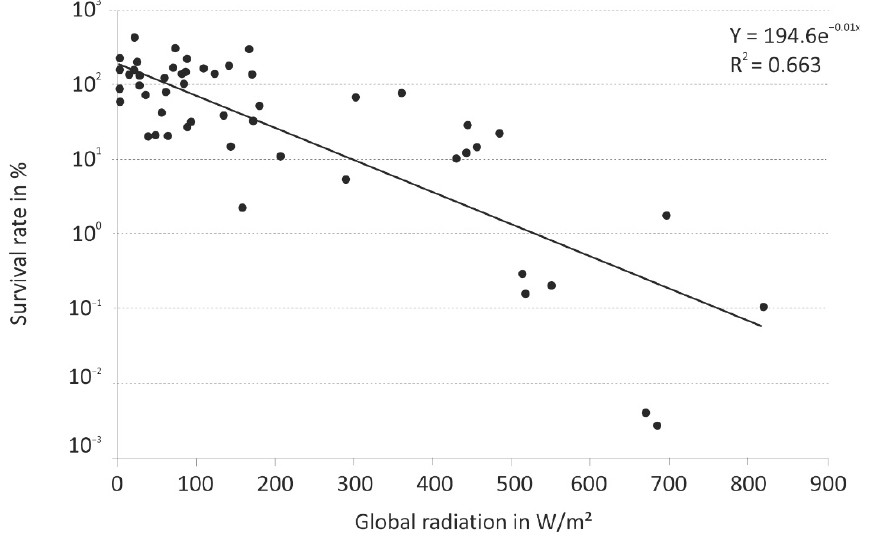
Figure 5. Survival rates of Staphylococcus xylosus after 12 min in the airborne state as a function of global radiation ( n = 54).